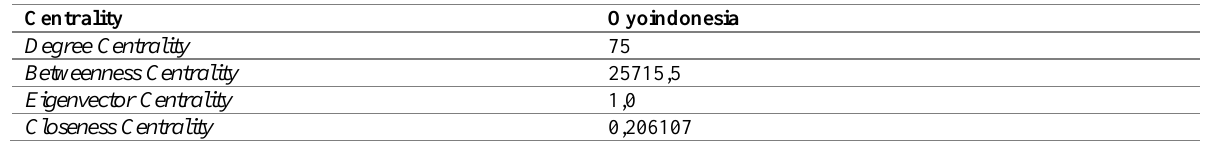
Table 4: Centrality Properties for OYO Social